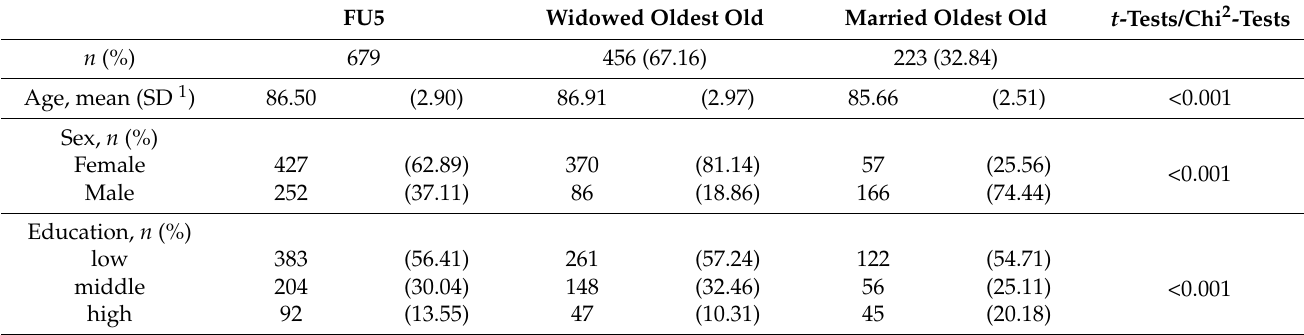
Table 1. Sociodemographic characteristics of the study sample ( n =